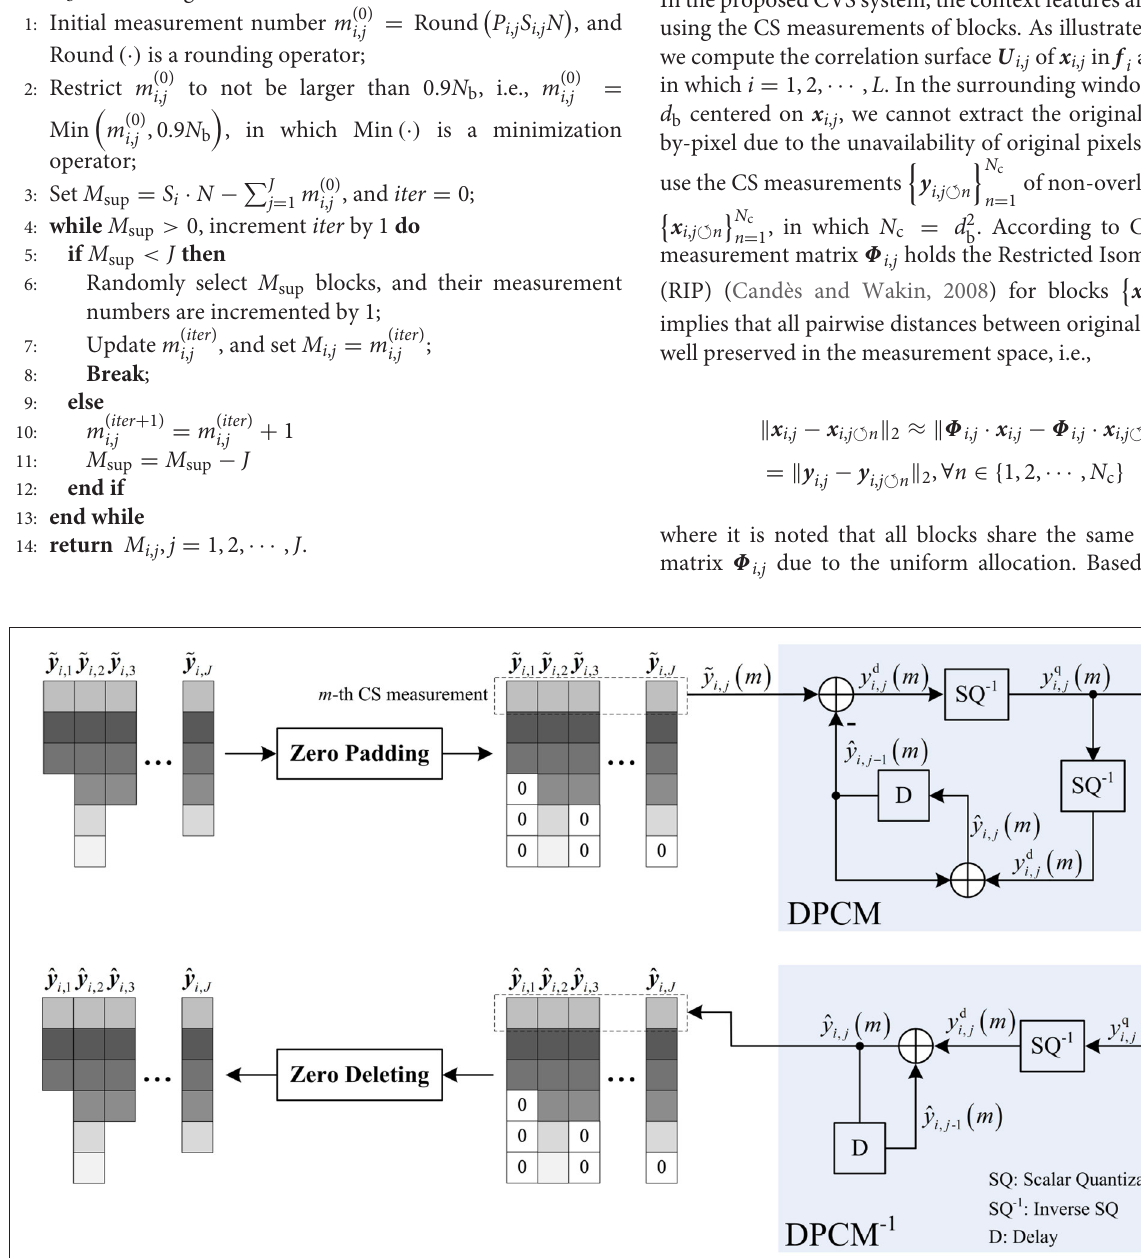
FIGURE 5 | Illustration on zero-padding Differential Pulse Code Modulation